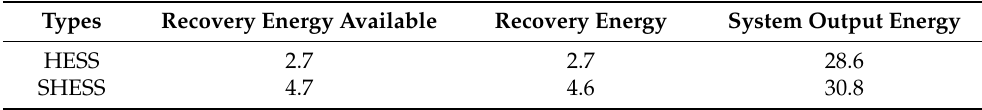
Figure 9. Flowchart and operating modes of hydraulic vehicle with an ethanol-fueled engine [82]: ( a ) HHV flowchart; ( b ) proposed operating modes. Table 4. Comparison of regenerative energy between HESS and SHESS